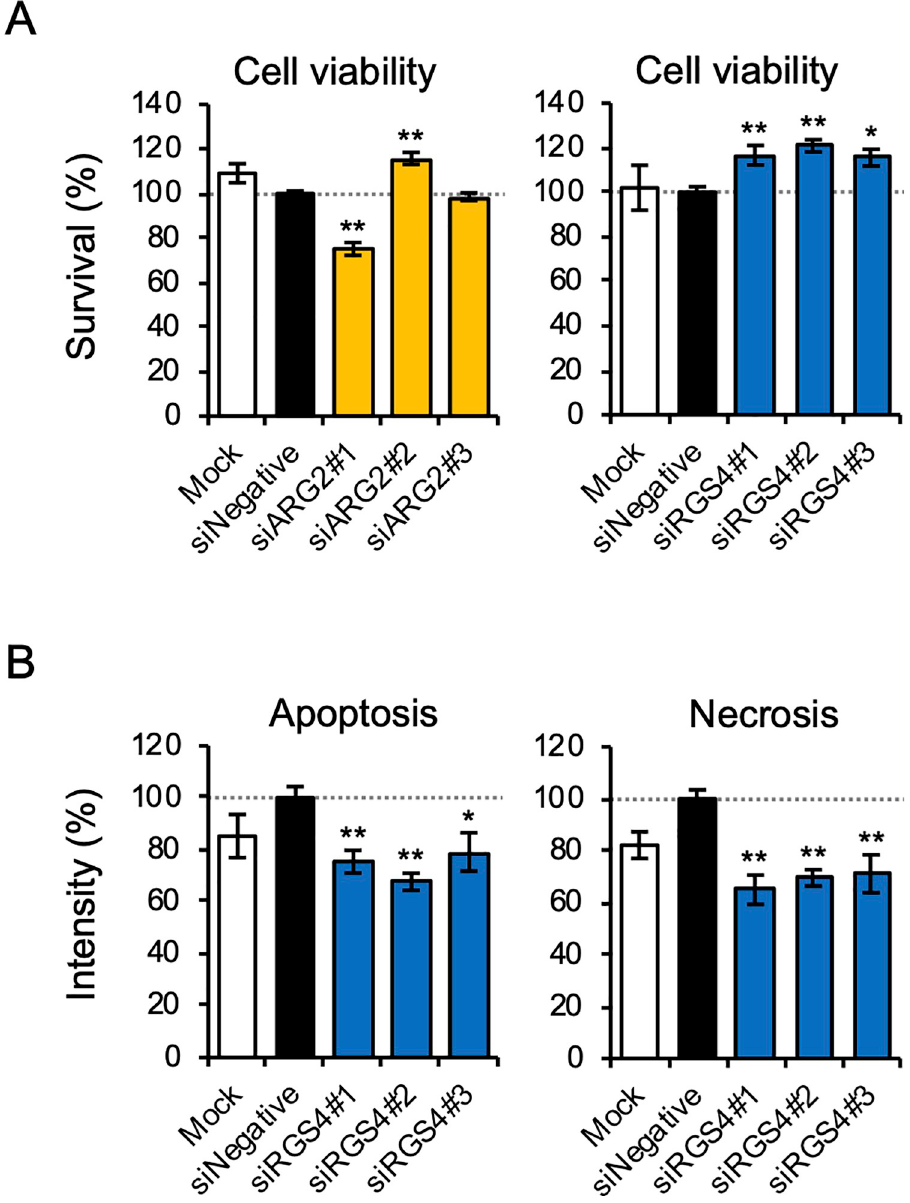
Fig 6. The effects of siARG2 or siRGS4 on AdNKX2-1-induced cell death, apoptosis, and necrosis. The number of surviving cells and apoptosis and necrosis signal intensities in siRNA-transfected cells are shown as a percentage of the control. siNegative-transfected cells were used as controls. ’Mock’ represents the Opti-MEM 1 Medium and Lipofectamine TM RNAiMAX exposed, but not siRNA transfected cells. Error bars indicate SEM. � p < 0.05, �� p < 0.01, significant differences between siNegative and siARG2 or siRGS4. (A) Viability of siARG2- or siRGS4-transfected cells 72 h after 300 MOI AdNKX2-1 infection (n = 9). (B) Apoptosis and necrosis in siRGS4-transfected cells 72 and 96 h, respectively, after 300 MOI AdNKX2-1 infection (n =